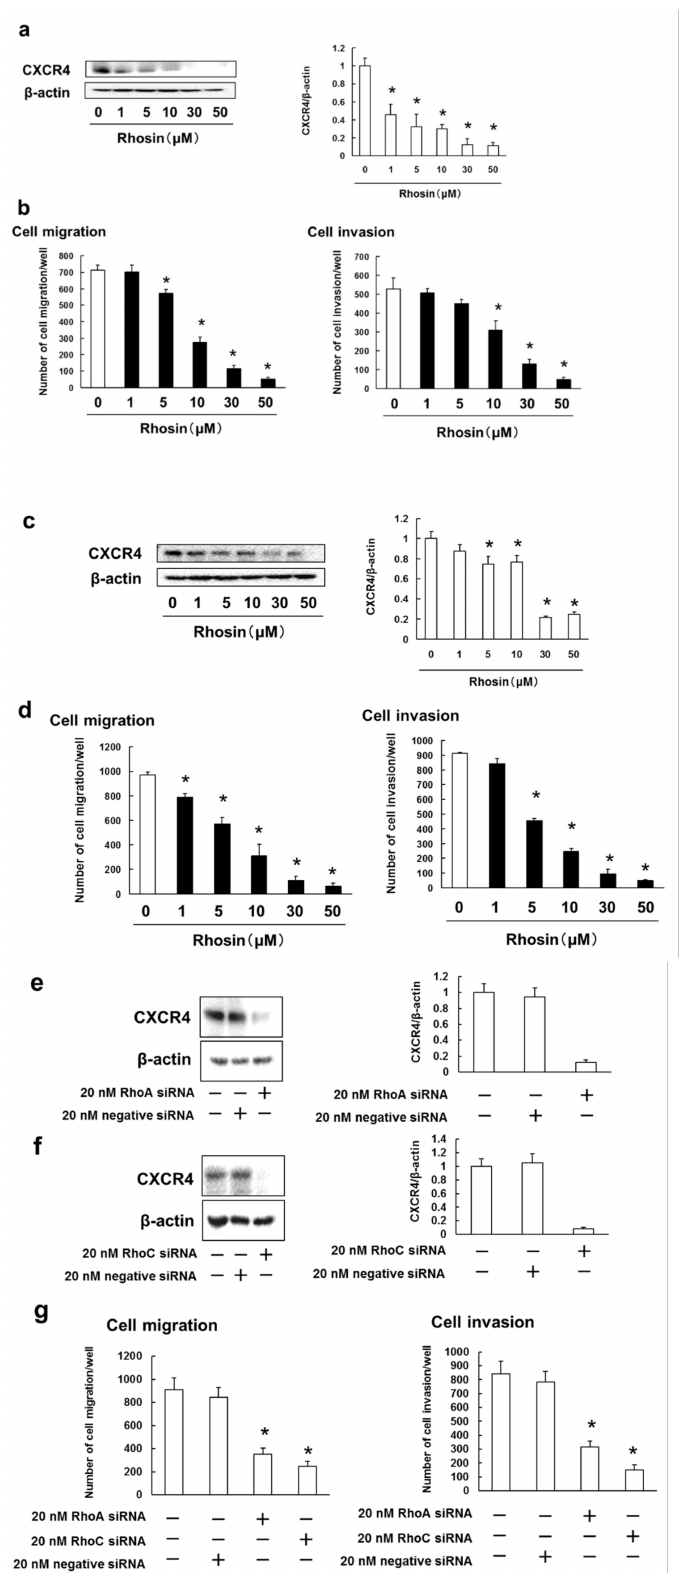
Figure 5. Rhosin suppressed SDF-1-induced cell migration and invasion via inhibition of CXCR4 expression: ( a ) B16BL6 cells were treated with rhosin at indicated concentration for 3 days. Images of Western blots for the CXCR4 and β -actin (internal standard), and quantification of the amounts of CXCR4 after normalization to the amounts of corresponding protein. The results are representative of 4 independent experiments. * p < 0.01 vs. controls (ANOVA with Dunnett’s test); ( b ) B16BL6